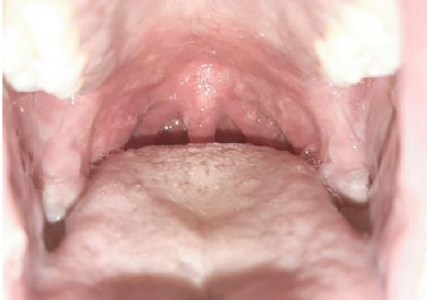
Figure 1: Mucosal involvement of the palate.